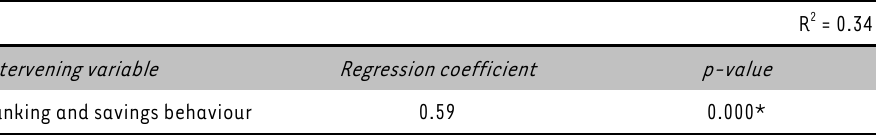
TABLE 3: Multiple regression analysis results for the influence of the intervening variable on the dependent variable responsible spending behaviour